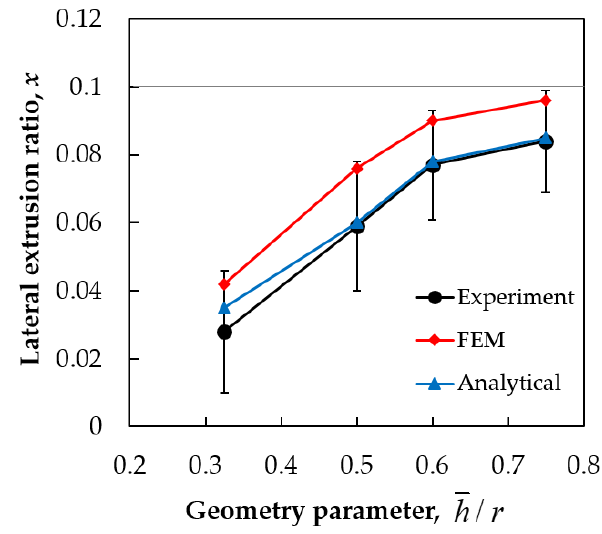
Figure 8. The dependence of the lateral extrusion ratio on the h / r parameter in the experiments with back-pressure of 110 MPa, by finite element simulations, as well as by the analytical model.